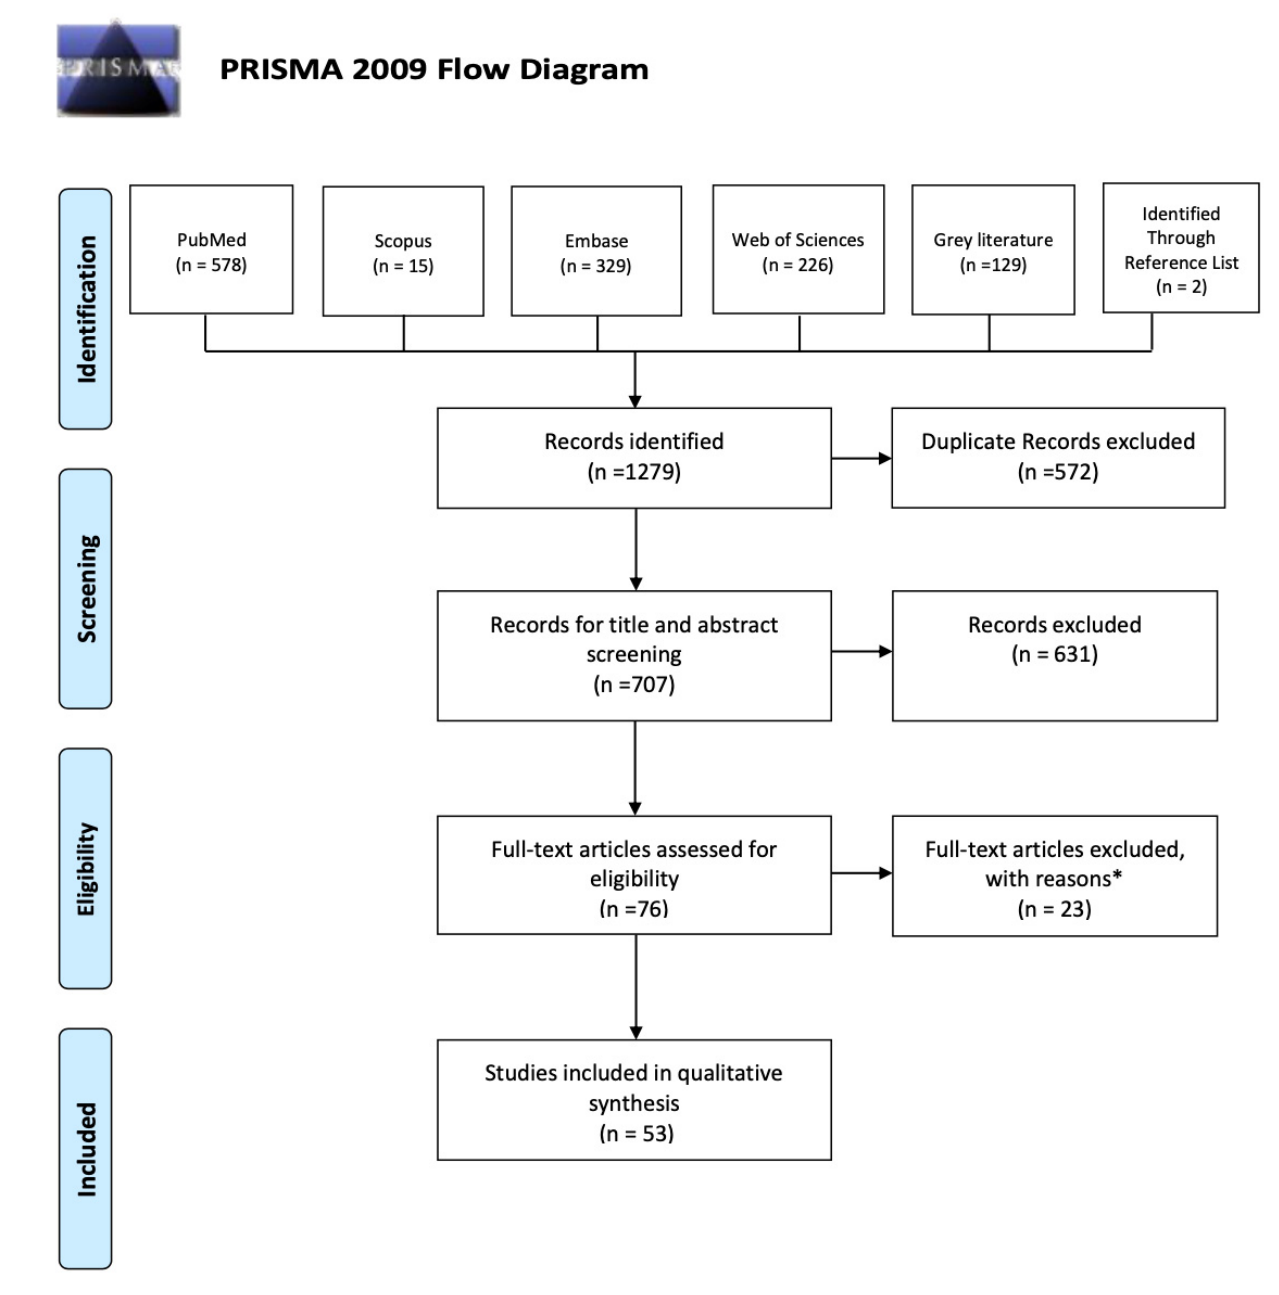
Figure 1. The Prisma Flow Diagram.